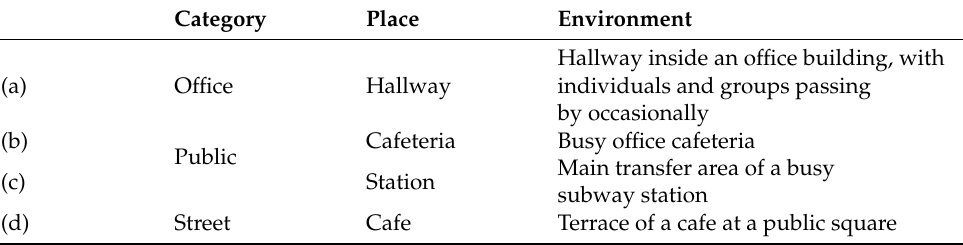
Table 3. Noise database structure: categories and recordings conducted in each